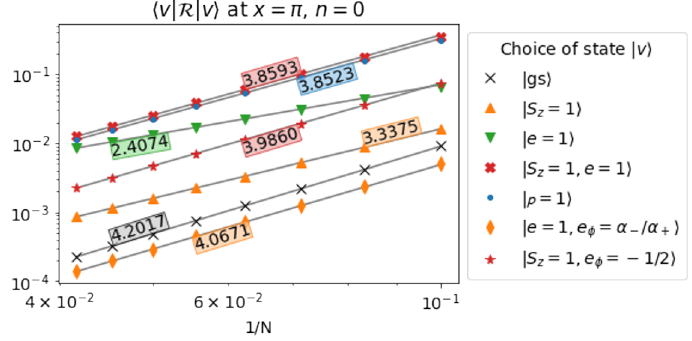
Figure 6 . Absolute value of matrix elements of R as de(cid:12)ned in (7.11), plotted using the same conventions as in (cid:12)gure 3 but with the choice of j u i = j v i